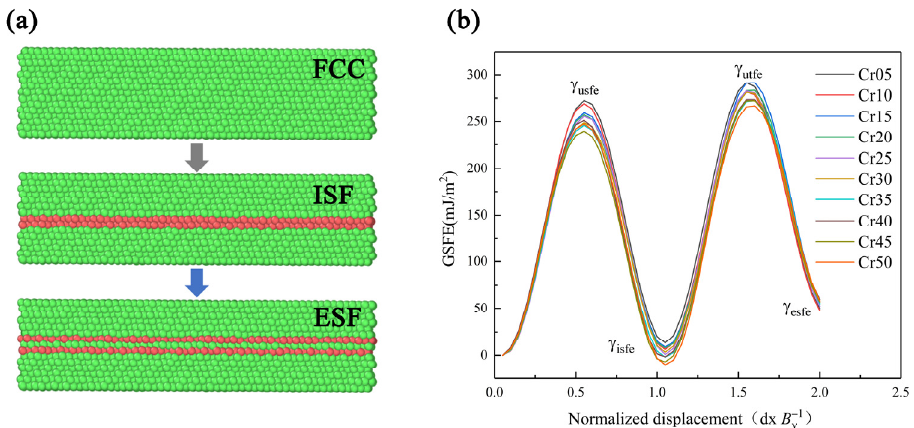
Figure 1. Simulation diagram ( a ) and curves of HEAs ( b ) of generalized stacking fault energy.